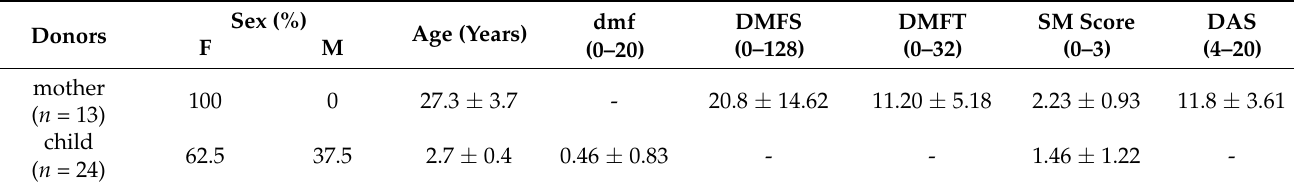
Table 1. Clinical parameters (mean ± SD) of strain